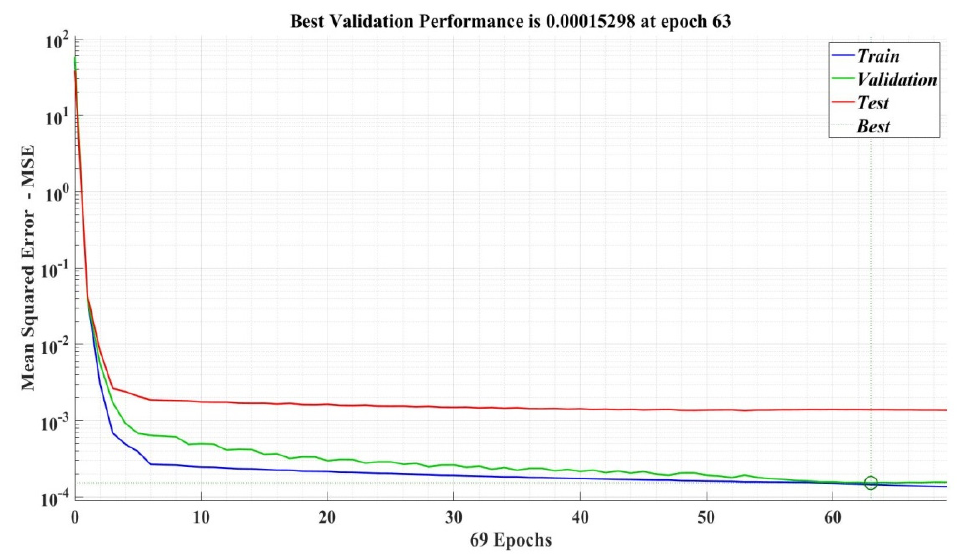
Figure 15. Performances of training for 2-FAL Analysis FFNN.